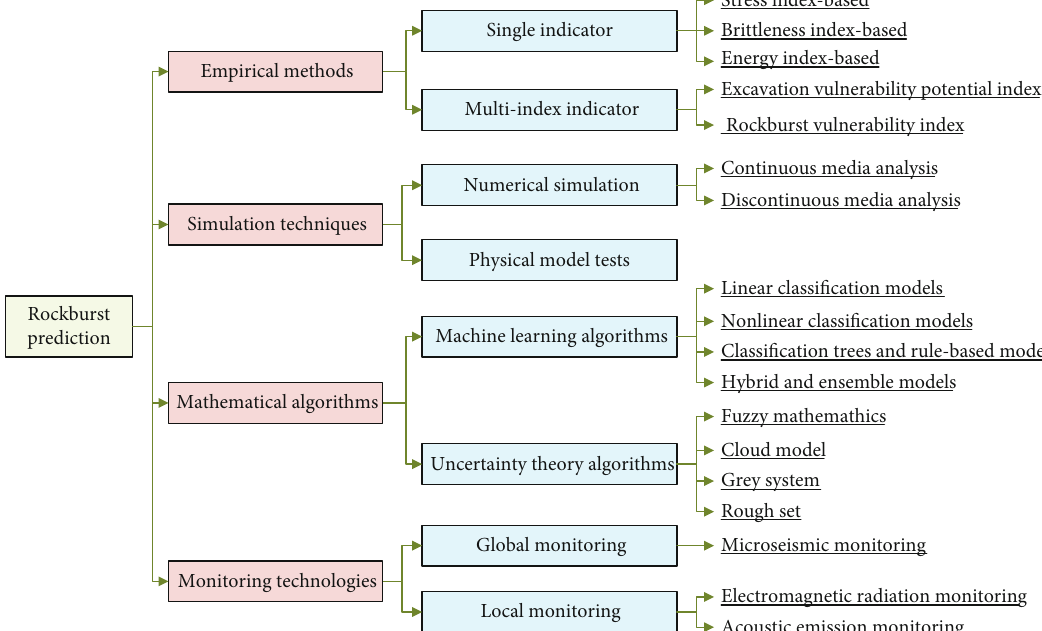
Figure 9: Approaches of di ff erent categories for rockburst prediction, modi fi ed from Reference [8].